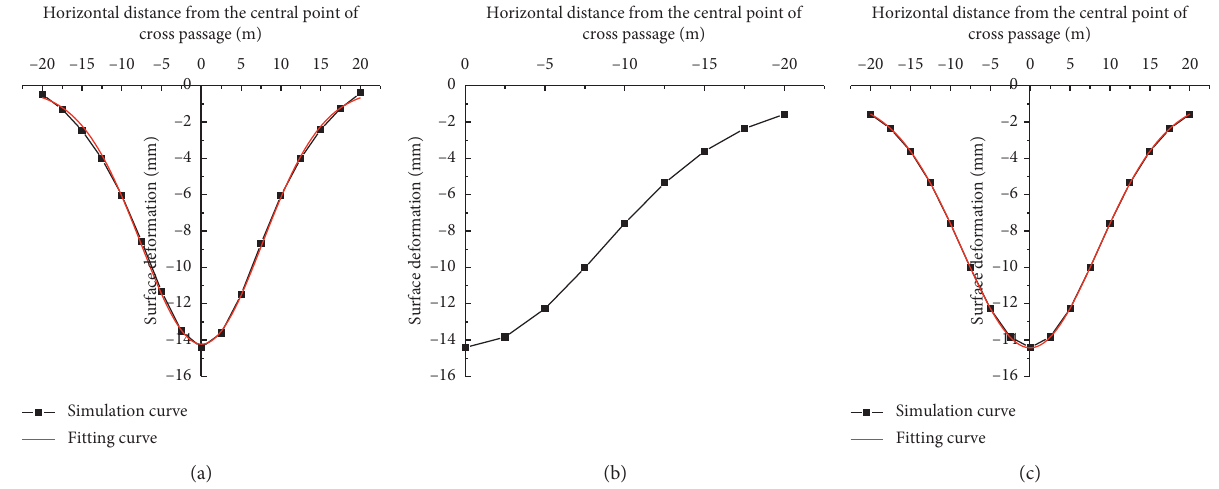
Figure 7: Distribution of the final surface thawing settlement: (a) along the centerline of the cross passage ( Y -direction), (b) along the centerline of the two shield tunnels ( X- direction), and (c) along the centerline of the two shield tunnels after symmetry ( X